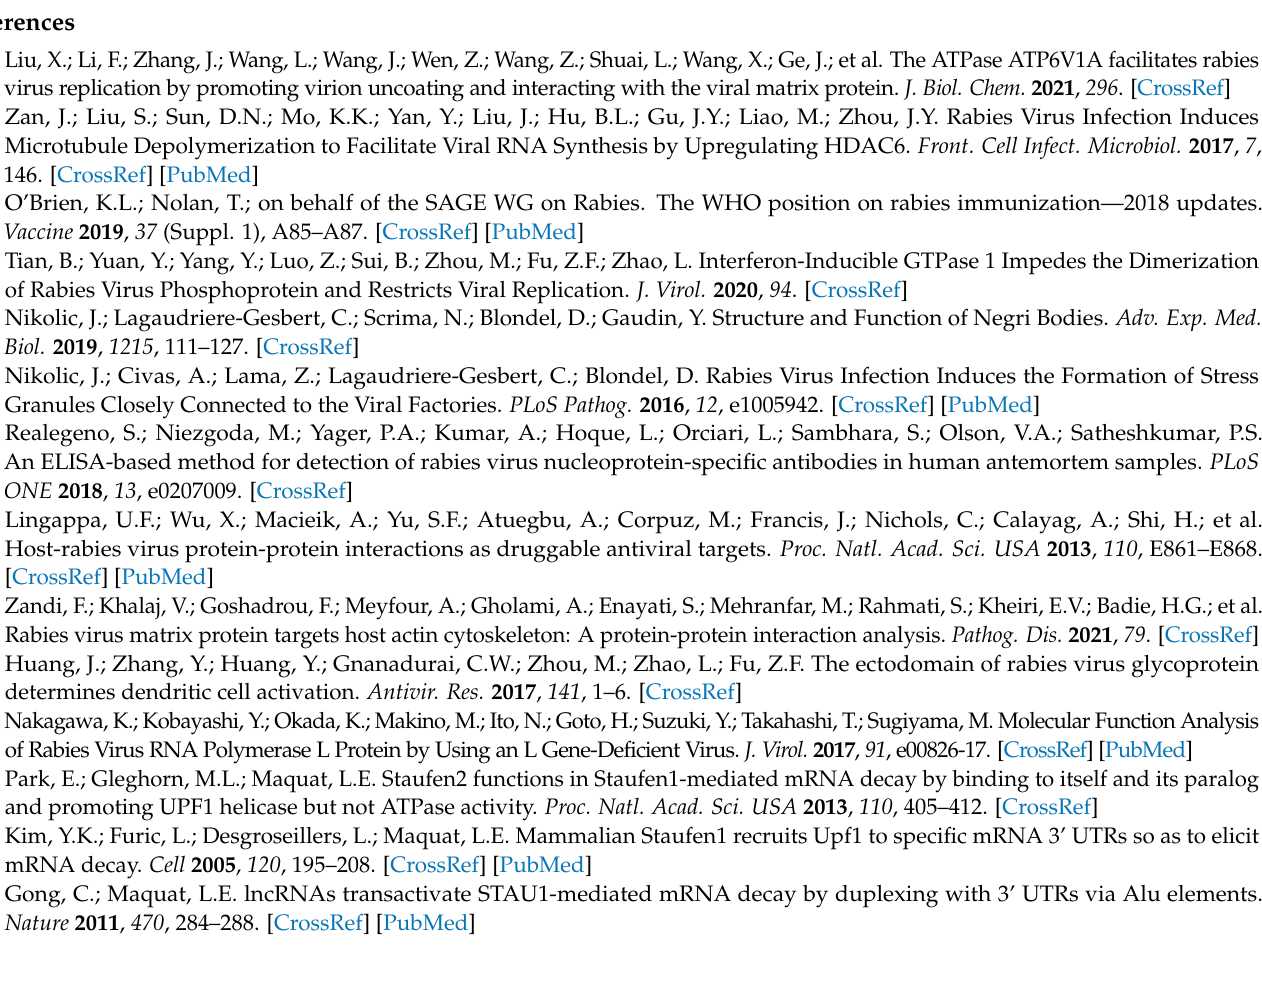
Figure S2: Subcellular distribution of Negri body-like structures formed in RABV-infected LV-shRNA- iSTAU1/LV-shRNA-iC